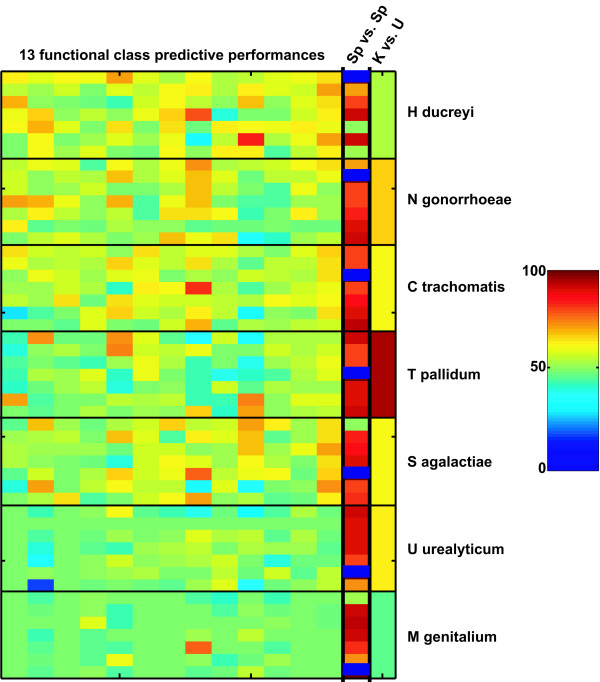
Summary of predictive performance and expected performance on proteins of unknown function. The first 13 columns show the AUCs for each functional class in each of the 7 × 7 species-species transfers. The order of functional classes and species is the same as in figure 1. The 14th column shows the corresponding species-species discrimination AUCs (from Figure 3) and the 15th column the distinction between known and unknown proteins for the species from which the classifier is derived (from Figure 2). To predict the expected performance on proteins of unknown function, find the species-species contrast that corresponds most closely to the known-unknown contrast of interest. The corresponding function prediction AUCs should give a reasonable estimate for the expected performance. It can be seen here that functional classes that are easily distinguished within a species will also successfully transfer between species, and such predictors (e.g. 'transport and binding', column 13) will also yield reliable results on the proteins of unknown function.